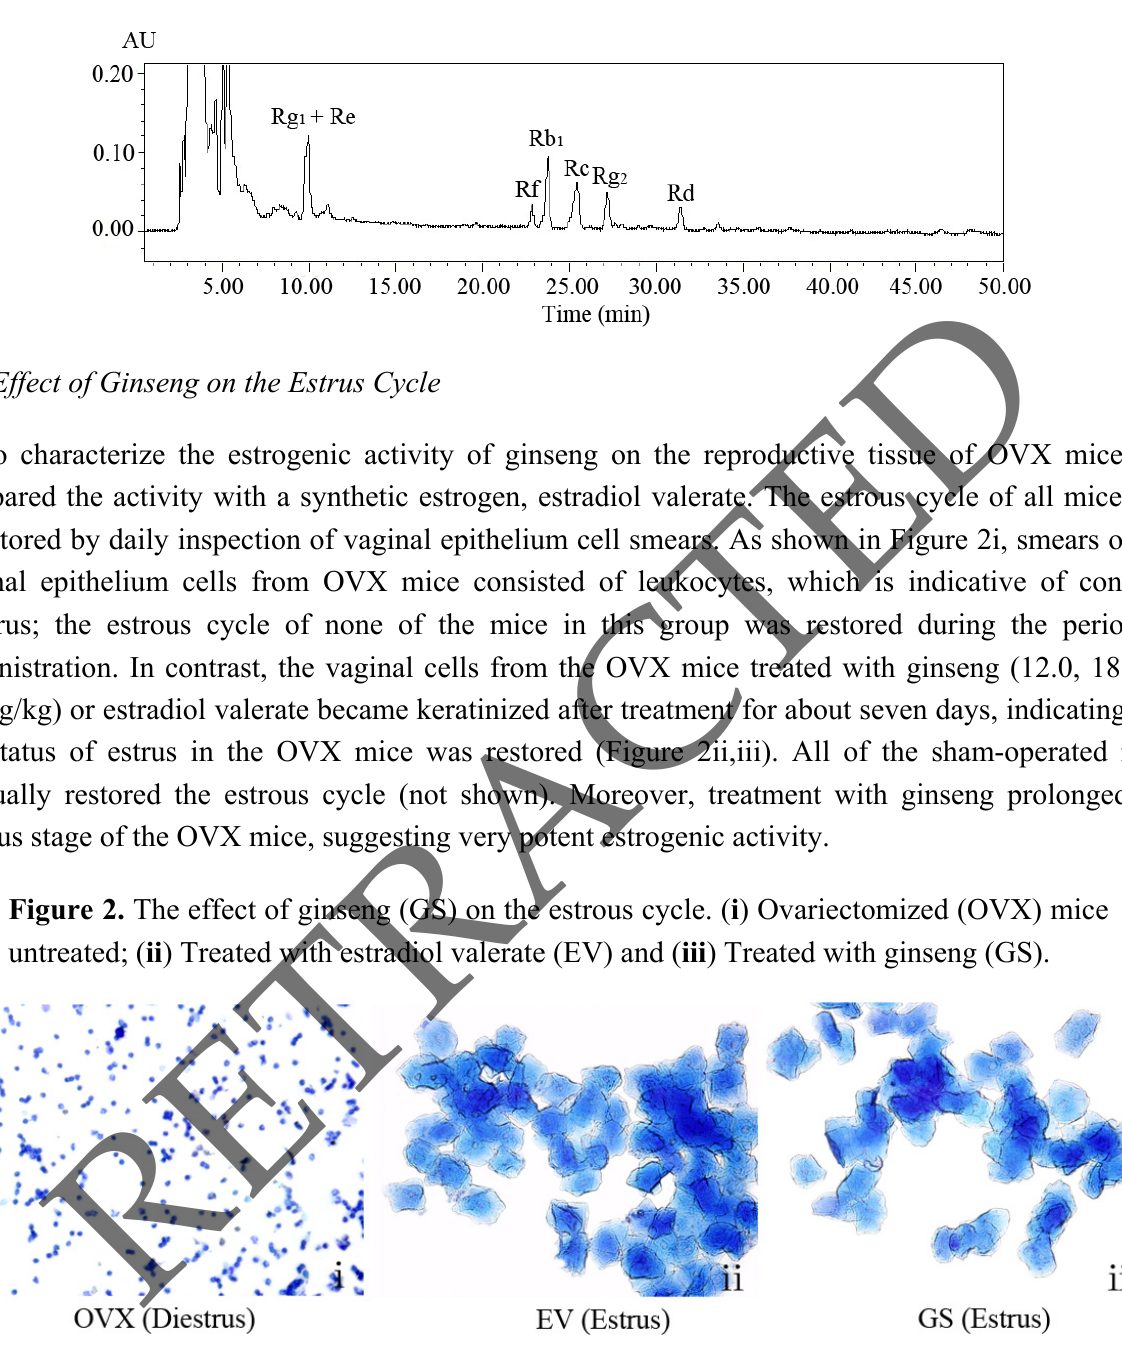
Vaginal epithelium cell smears were taken at the seventh day from ovariectomized (OVX)